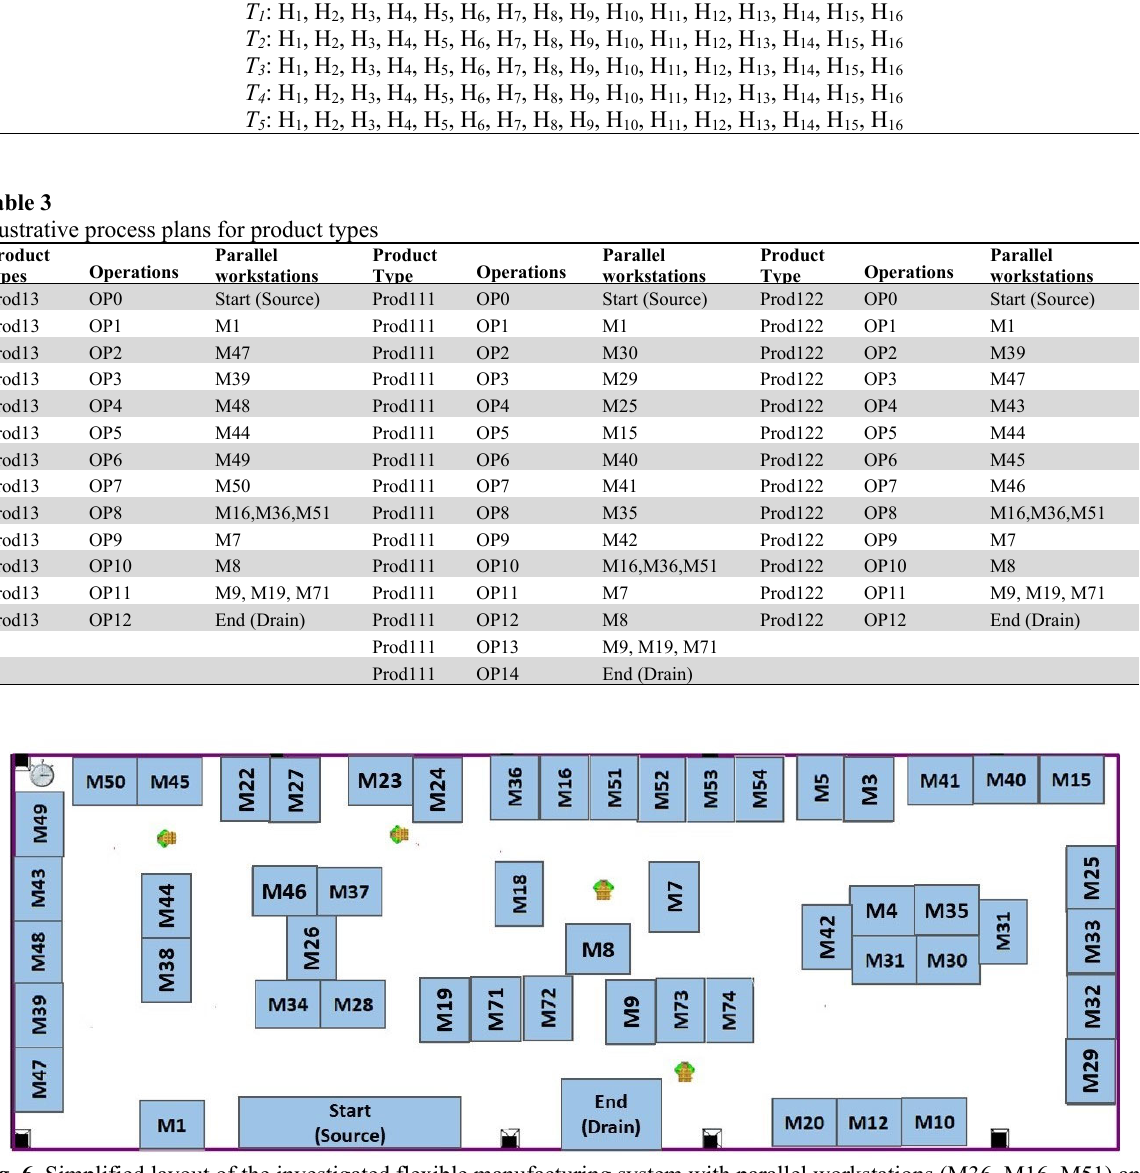
Fig. 6. Simplified layout of the investigated flexible manufacturing system with parallel workstations (M36, M16, M51) and (M9, M19,